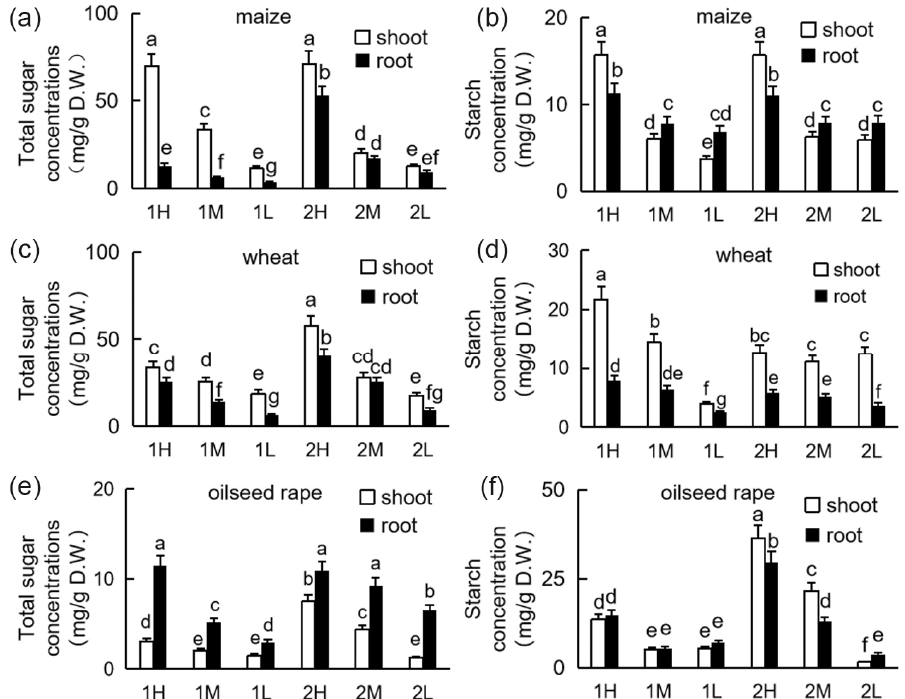
Figure 2. Sucrose and starch concentrations of maize, wheat, and oilseed rape seedlings under different light conditions: 20-day-old seedlings were subjected to one week of relatively high-light treatment (1H), one week of medium-light treatment (1M), one week of relatively low-light treatment (1L), two weeks of relatively high-light treatment (2H), two weeks of medium-light treatment (2M), or two weeks of relatively low-light treatment (2L). D.W.: dry weight. Sucrose concentrations of maize ( a ), wheat ( c ), and oilseed rape ( e ) seedlings. Starch concentrations of maize ( b ), wheat ( d ), and oilseed rape ( f ) seedlings. Bars represent standard deviations of 3 independent replicates (3 seedlings per replicate). Values followed by different letters are significantly different at p < 0.05 according to Duncan’s multiple range